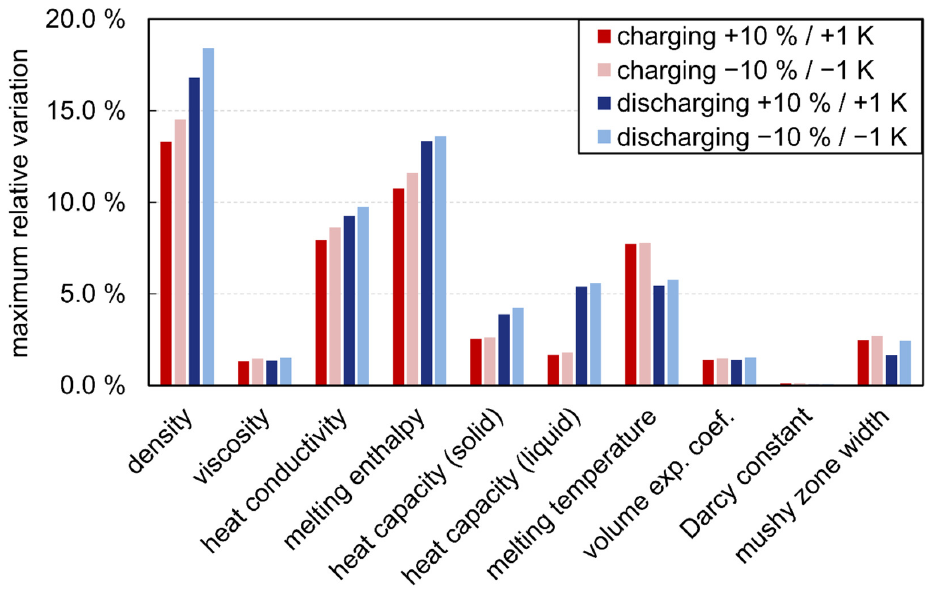
Figure 7. Absolute maxima of the relative variation of the power for charging and discharging when varying the material properties by ±10% or ±1 K .